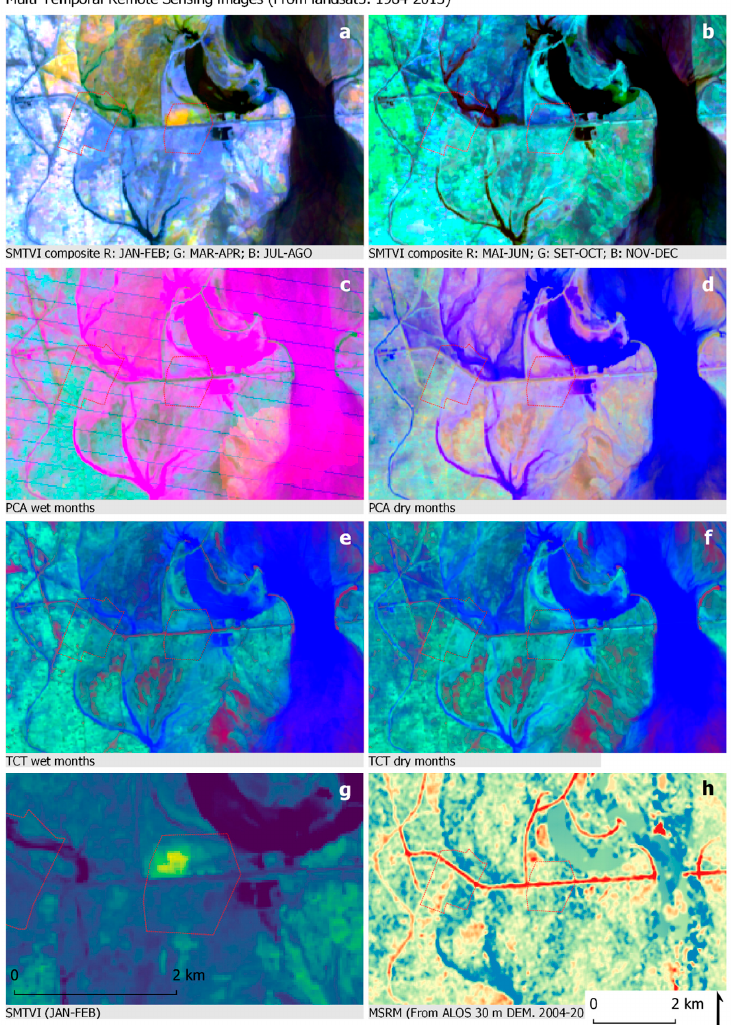
Figure 11. Detail of the area were DG Khan was situated until 1909 in Multi-Temporal RS products: SMTVI ( a ) wet and ( b ) dry months; PCA ( c ) wet and ( d ) dry months; TCT ( e ) wet and ( f ) dry months; (g): Detail of the area occupied by the old DG Khan town, with an anomaly in the Northeastern sector visible in the months of January-February. MSRM (h) image of the same area. Blue represents relative lower areas and red higher areas.